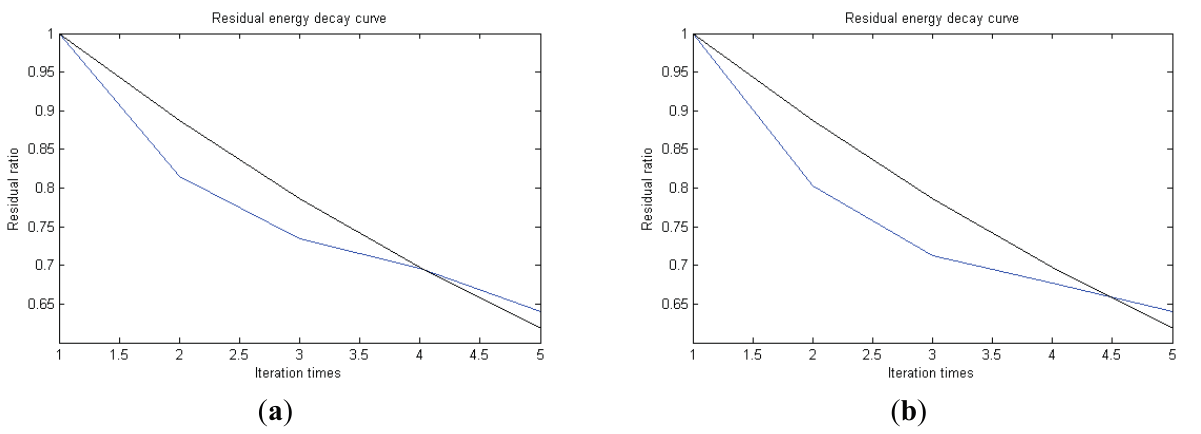
Figure 35. Residual energy decay curve: ( a ) first 512 points; ( b ) last 512